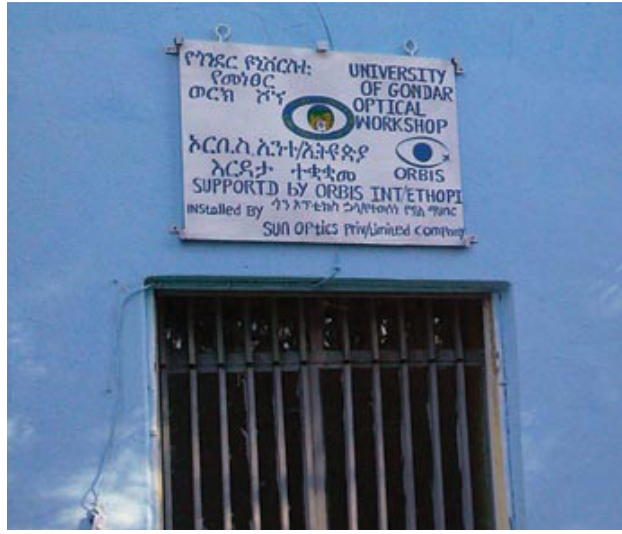
Figure 4 The entrance to the optometry workshop and